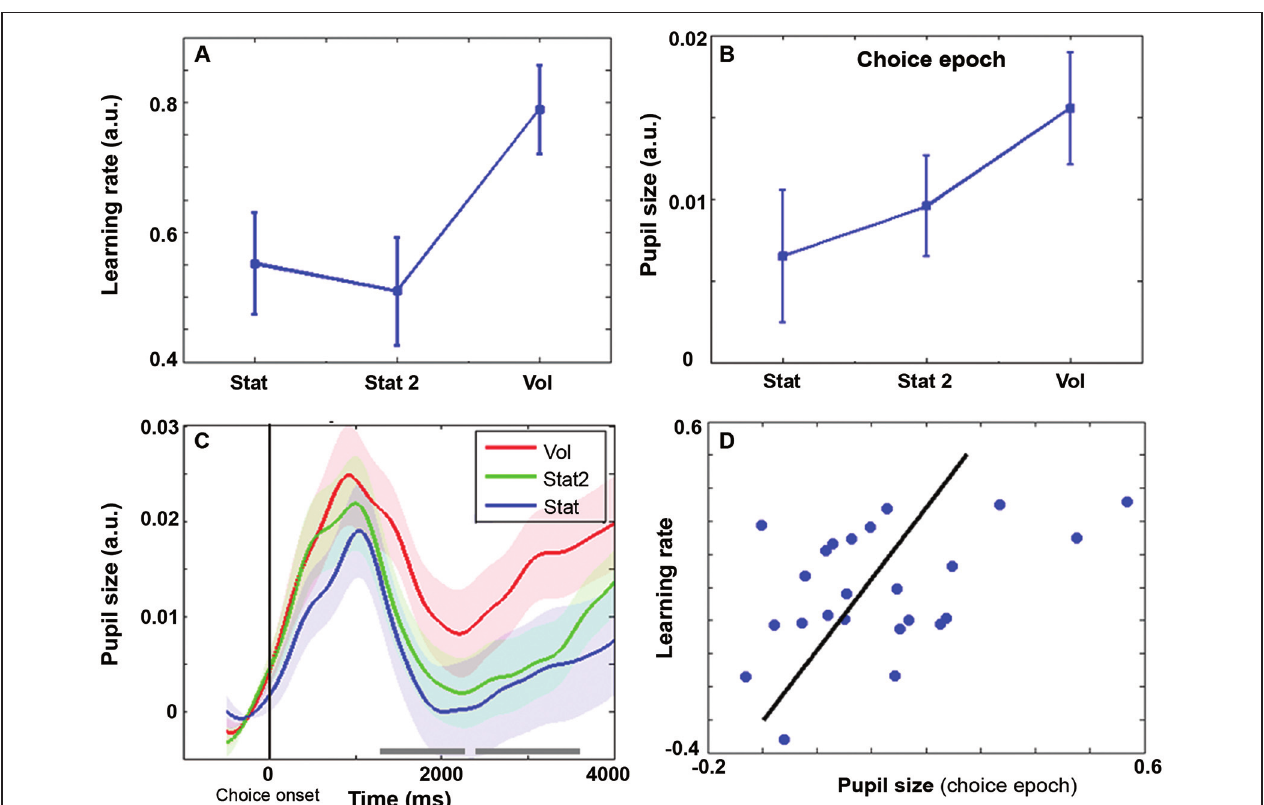
the difference between Vol and Stat2 is significant (cluster level family-wise corrected p < .05) (D) Scatter plot representing the covariation between pupil size and learning rate during the Vol period. Each data point is a single subject average. Regression line is shown in